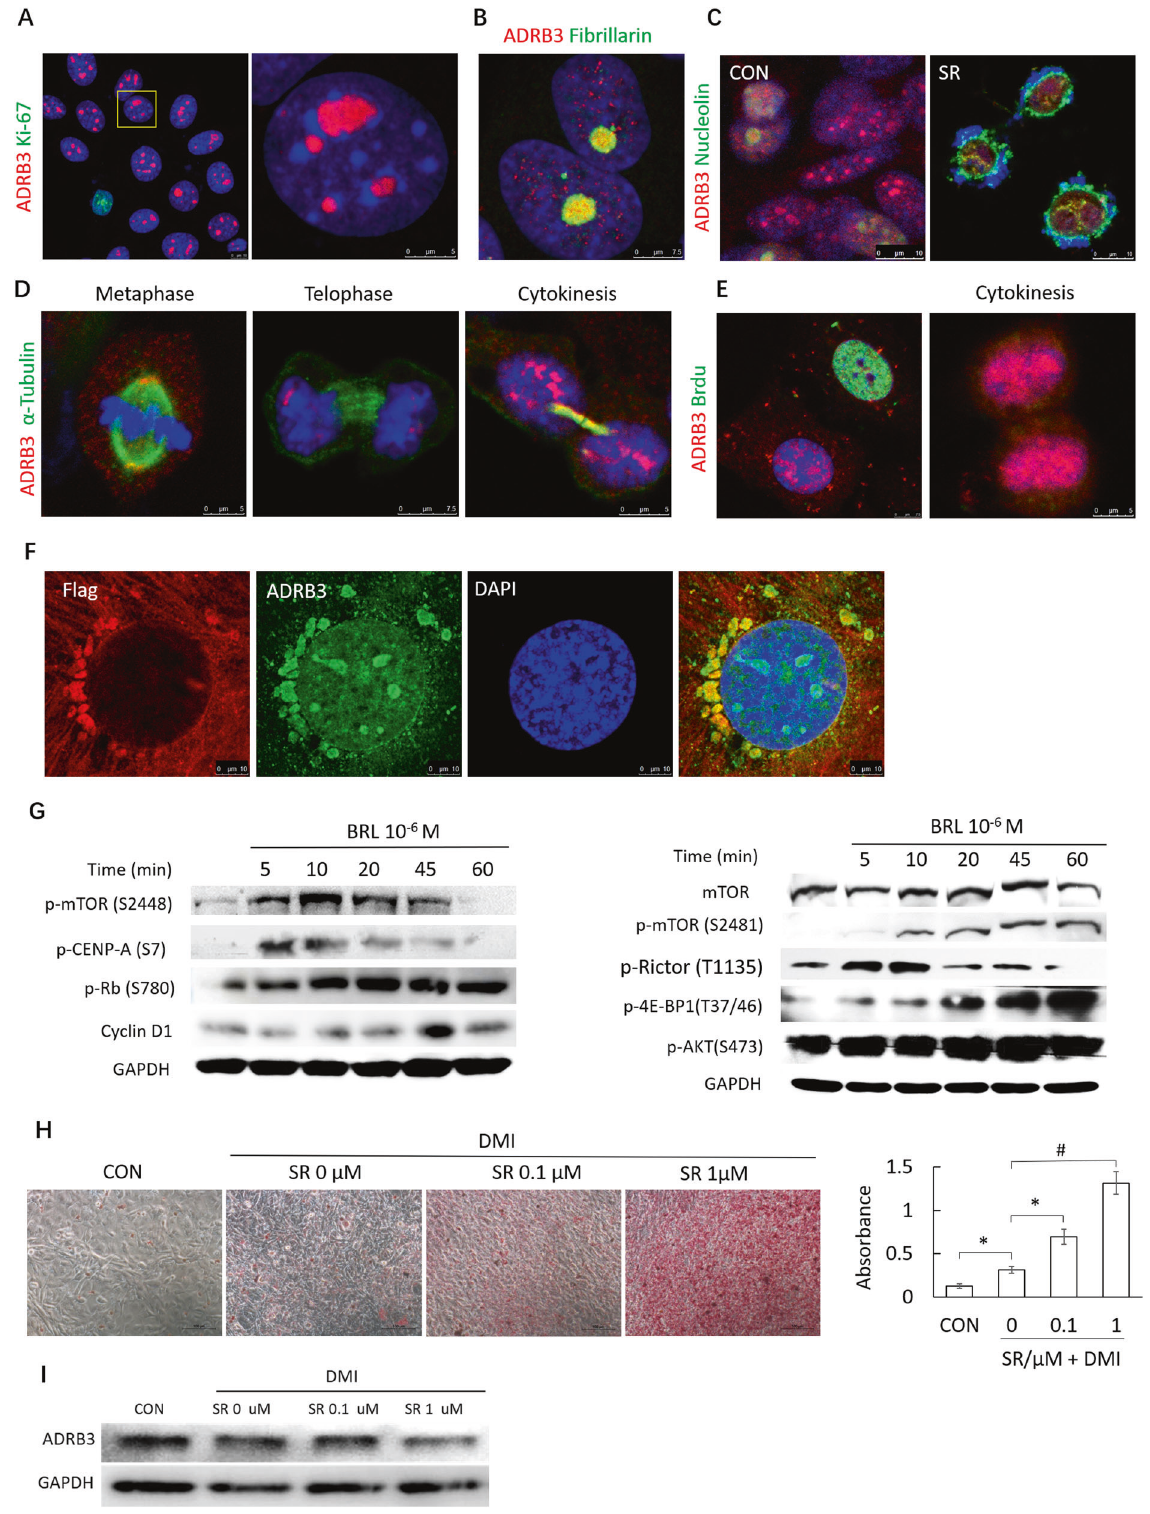
The results showed that SR59230A led to slower growth rate and smaller tumor volume (321.3 ± 51.4 mm 3 ) compared with the control group (762.7 ± 74.8 mm 3 ; P < 0.05) (Fig. 4A, B).